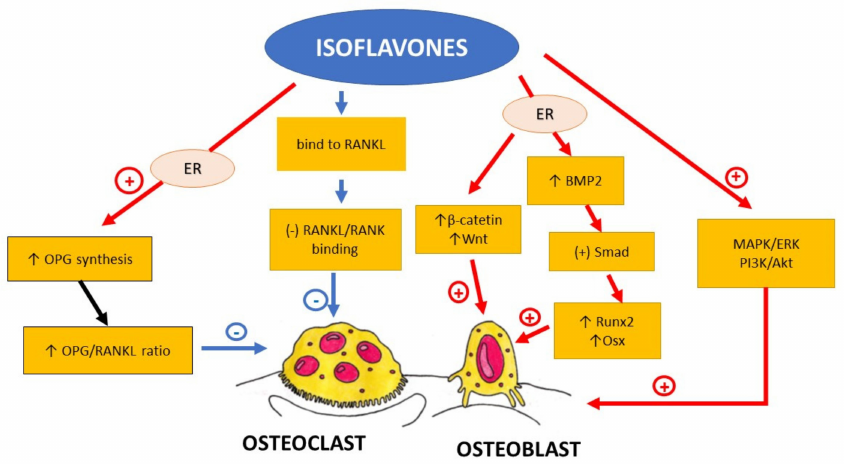
Figure 3. Schematic diagram representing the influence of isoflavones on proliferation, differentiation and activity of osteoclasts and osteoblasts. BMP2—bone morphogenic protein 2, ER—oestrogen recep- tor, MAPK/ERK—mitogen-activated protein kinase/extracellular signal-regulated kinases signalling pathway, OPG—osteoprotegerin, Osx—Osteoblast-specific transcription factor Osterix, PI3K/Akt- phosphoinositide-3-kinase/serine-threonine kinase signalling pathway, —Receptor Activator for Nuclear Factor κ B, RANKL—Receptor Activator for Nuclear Factor κ B Ligand, Runx2—Runt-related transcription factor 2, ↑ —increased, ↓ —decreased, (-)—inhibited,